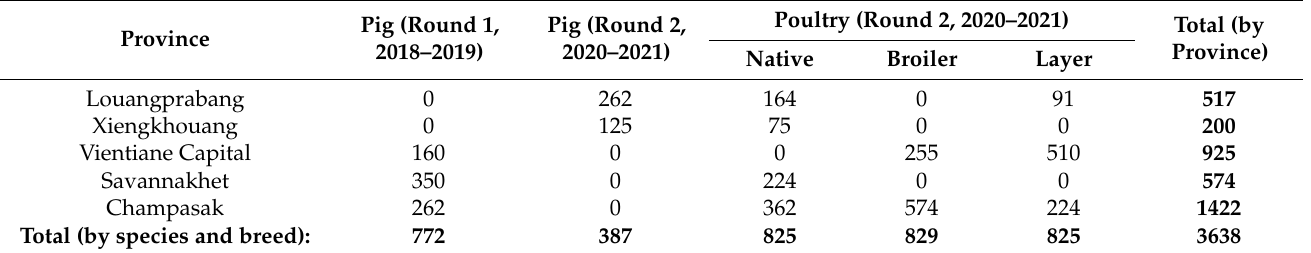
Table 1. Collection of pig and chicken caecal specimens during two rounds of antimicrobial resistance surveillance in five provinces in the Lao PDR,